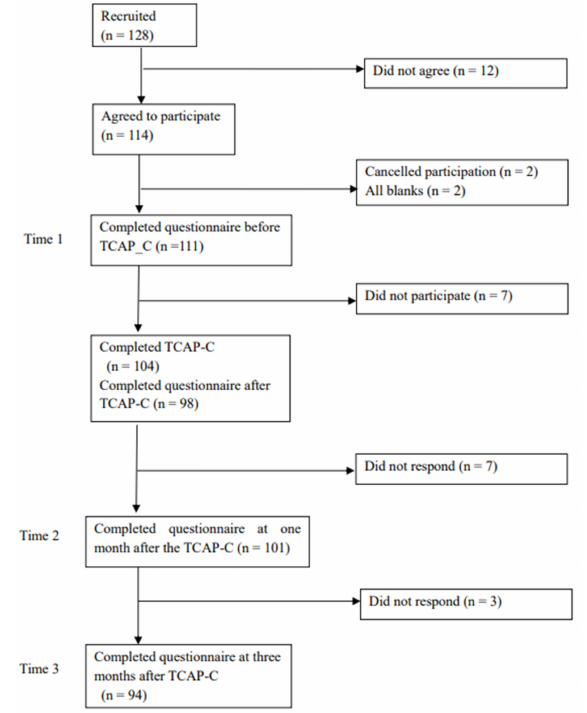
Figure 2. Flow of